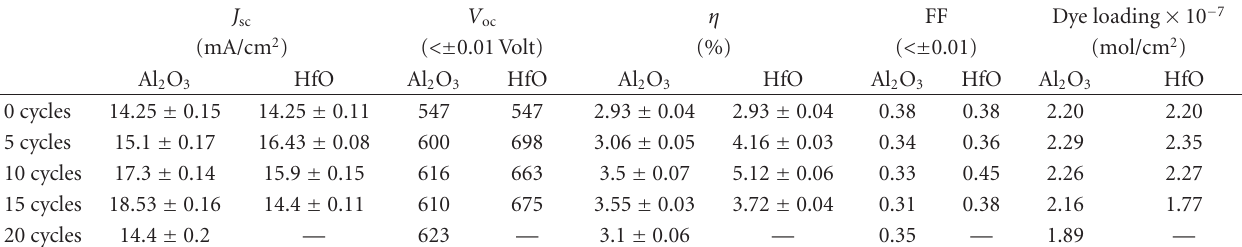
Table 1: The DSC performance parameters for alumina and hafnia ALD Nb:TiO 2 photoanode coated with di ff erent